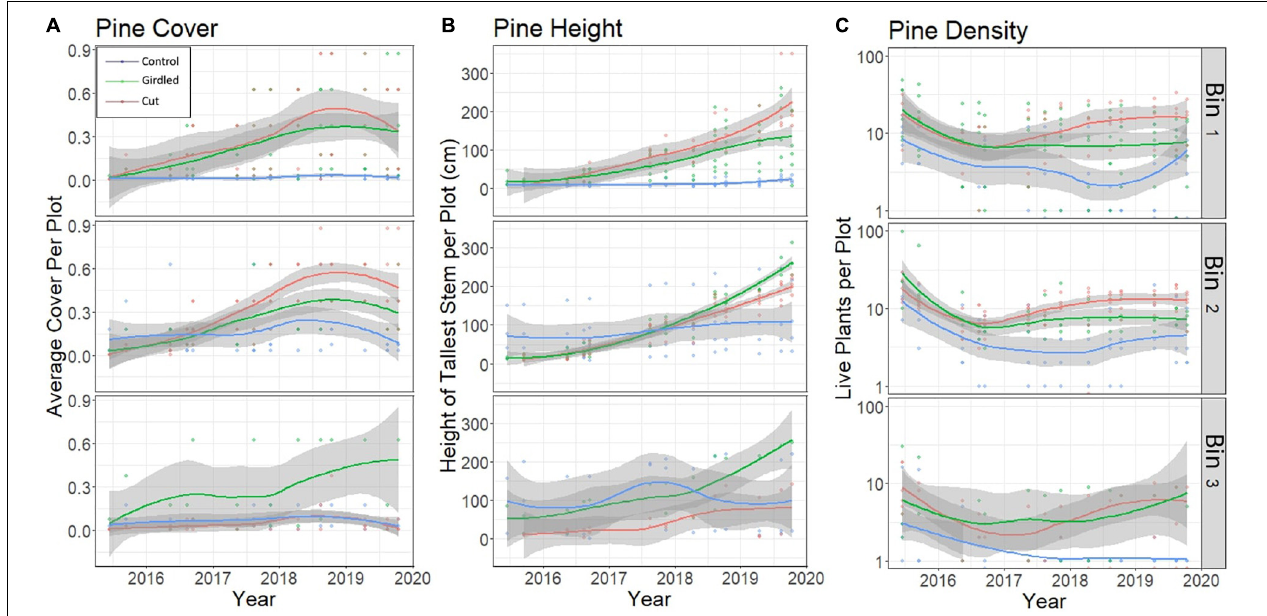
FIGURE 4 | Multiple metrics to represent forest recovery (e.g., pine tree regrowth) at the Moneystump Swamp transgression experiment (Cambridge, MD, United States) over time for the high forest (bin 1), low forest (bin 2), and marsh forest transition (bin 3). (A) Change in cover class over time for understory P. taeda seedlings and saplings. (B) Change in height for tallest understory P. taeda in each plot. (C) Count of individuals in the understory, or density of P. taeda per 2 m 2 plot. Each plot is color-coded for treatment, red is Cut, green is Girdled, and blue is Control. Trend lines depict Loess-smoothed local polynomial regression, with the shaded area around the trend lines showing the standard